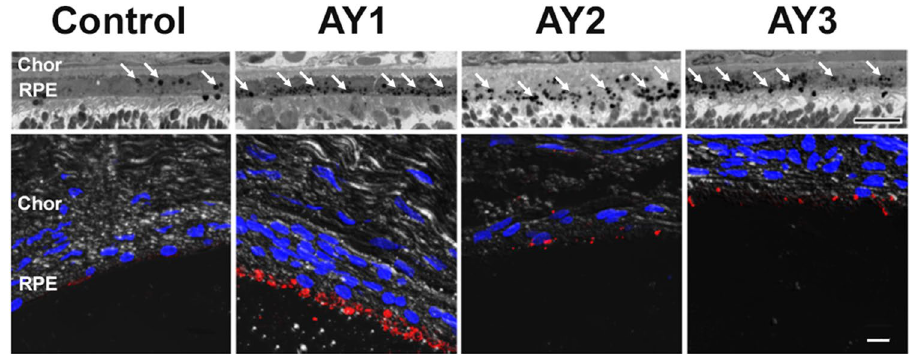
Figure 2. Persistence of phagosomes in RPE of AY9944-treated rats. Upper panels : Higher-magnification light microscopy images of RPE (resin embedment; 100X oil objective and 3X digital zoom) at PN 80 days, under same dietary conditions as in Fig. 1. White arrows denote presumed phagosomes in RPE. Lower panels : Correlative immunohistochemistry (paraffin embedment; confocal fluorescence microscopy), using anti-opsin (1D4 epitope) and fluor-conjugated secondary IgG ( red ) to label phagocytized photoreceptor outer segment tips in RPE. DAPI counterstain ( blue ). Note the relative paucity of 1D4-positive material in the control RPE, compared to the marked amount of such material in the RPE in AY9944-treated rats. Scale bars, 10 μ m. Abbreviations : Chor, choroid; RPE, retinal pigment